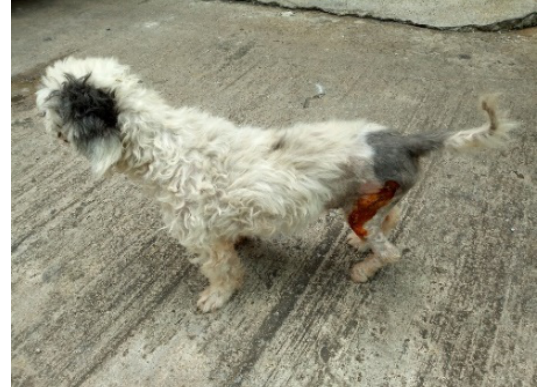
Fig. 14. Old dog could be performed weight baring